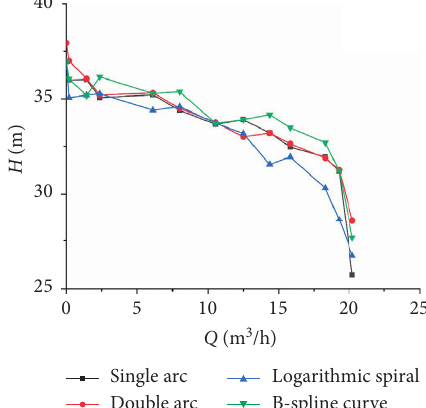
Figure 13: Q - H curves of four profiles.